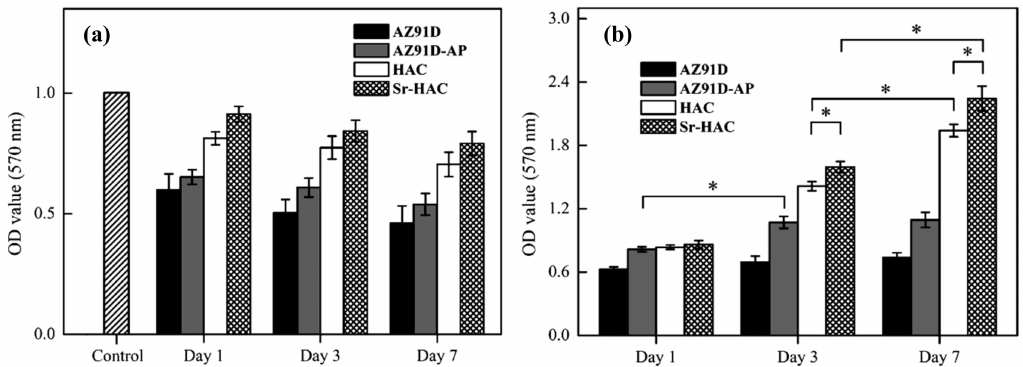
Figure 12. MTT optical density measurements of osteoblastic cell viability for MG63 cells cultured ( a